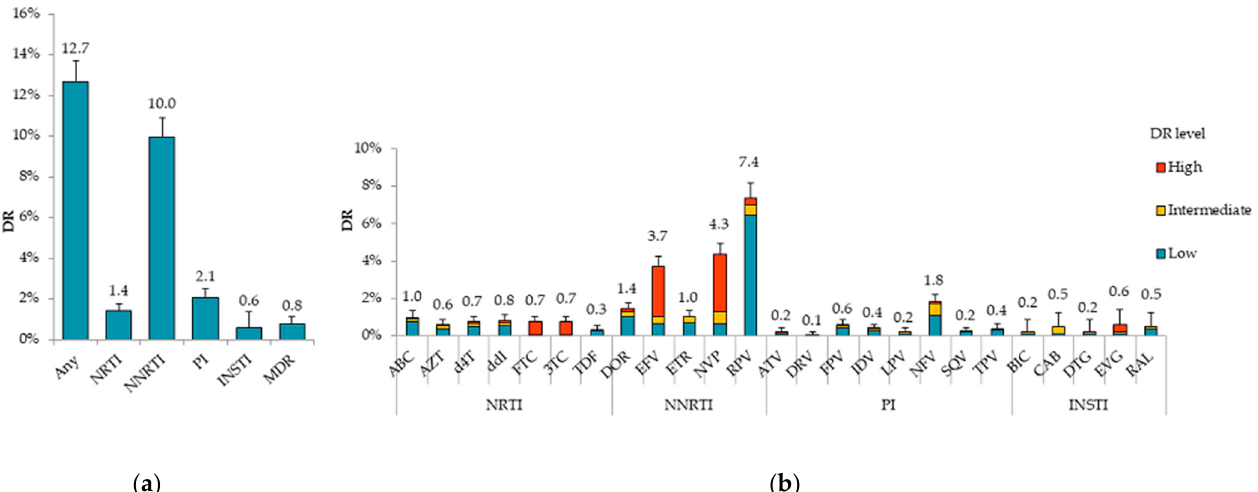
Figure 4. HIV DR prevalence in Russia in the 2006–2022 sampling years by ( a ) drug class and ( b ) antiretroviral drugs with DR levels. PR-RT (n = 4481) and INT (n = 844) sequences were used to analyze DR to NRTIs, NNRTIs, PIs, and INSTIs, respectively. Error bars represent 95% CIs. Abbreviations: NRTI, nucleoside reverse transcriptase inhibitor; NNRTI, non-nucleoside reverse transcriptase inhibitor; PI, protease inhibitor; INSTI, integrase strand transfer inhibitor; MDR, multidrug-resistance; ABC, abacavir; AZT, zidovudine; FTC, emtricitabine; 3TC, lamivudine; TDF, tenofovir; d4T, stavudine;